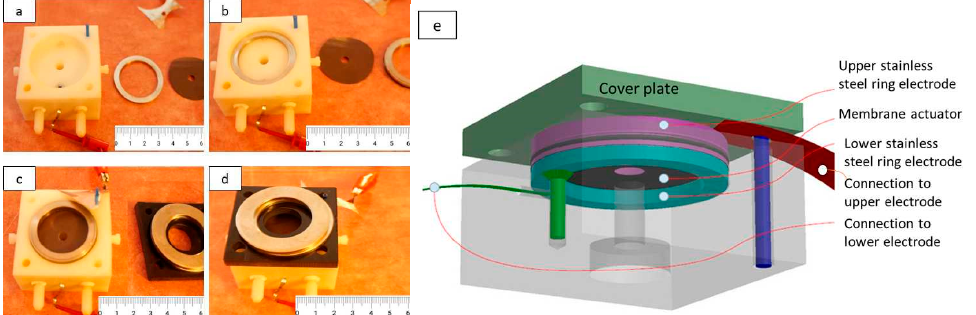
Figure 1. Assembly steps of the measurement device (scale bar 6 cm) ( a – d ) with an M2 membrane: the lower electrode as the counter-electrode and the upper electrode as the working electrode. A schematic view of the device with the electrodes, the membrane actuator and the connections in place ( e ).